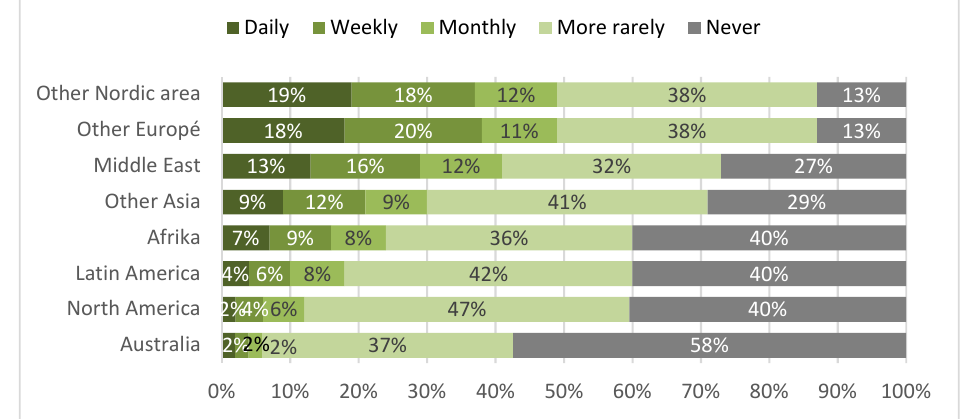
Figure 3. Frequency of socializing with people from other parts of the world ( n = 1035). There was no difference between male and female respondents concerning the fre- quency of interaction with people of a non-European background. Swedes in all age groups up to 65 years had more frequent contact with people of a non-European back- ground, as compared to the Swedes above 65 years. The percentage of respondents with good or very good experiences of working or studying with colleagues with foreign backgrounds was 74%, equaling the result from 2018. This result, together with the result from 2018, was the highest ever recorded. Over the long term, the results show a sustained increase in positive experiences (see Figure 4).